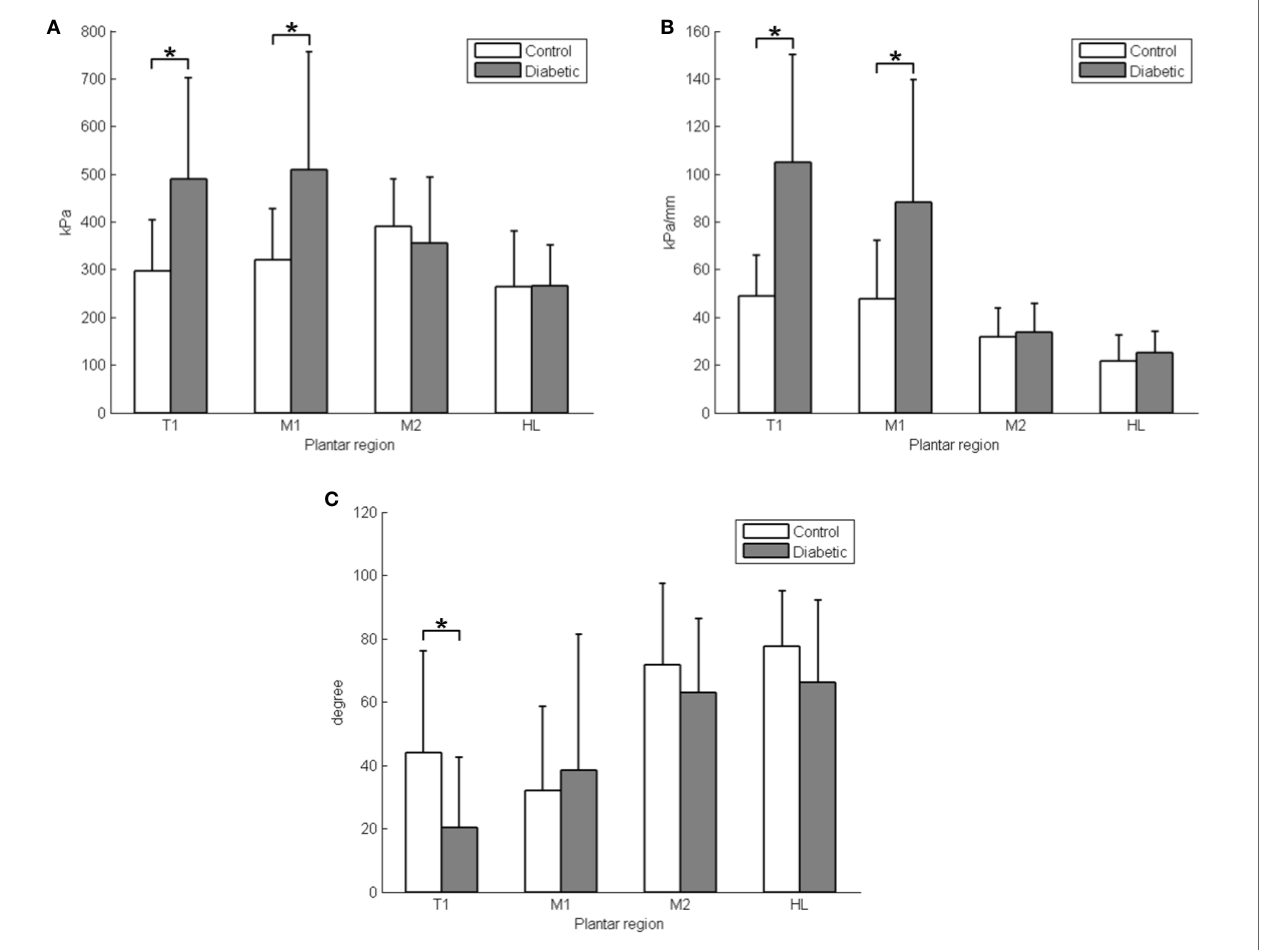
FigUre 3 | The comparison of PPP, PPg, and Pga between the diabetic and control groups . (a) Peak plantar pressure (PPP); (B) peak pressure gradient (PPG); (c) pressure gradient angle (PGA). T1, first toe; M1, first metatarsal head; M2, second metatarsal head; and HL, heel; * P < 0.05, values are means with